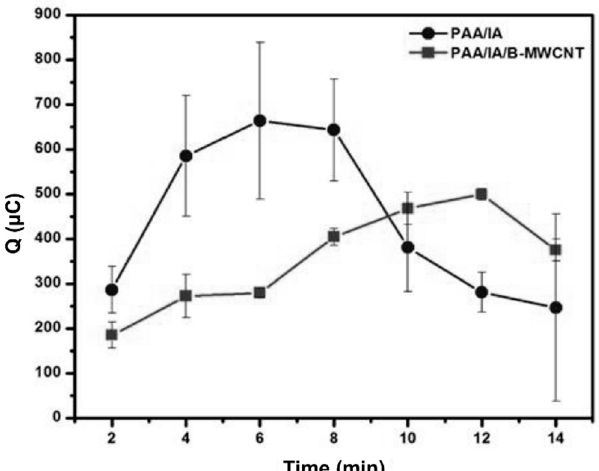
Figure 7. E ff ect of accumulation time on Cd(II) in CPE modified with either PAA-co-IA / NaOH (PAA / IA) or PAA-co-IA / NaOH / B-MWCNT (PAA / IA / B-MWCNT) hydrogel in a solution of Cd(II) 1 × 10 − 3 M + KNO 3 0.1 M at pH 5. Each point was obtained by DPV using the following conditions: The accumulation time was 2 min at open circuit potential under stirring, and the pre-concentrated Cd(II) was reduced to Cd(0) at − 0.95 V for 40 s, followed by anodic stripping (oxidation of Cd(0) to Cd(II)) from − 0.95 to 0.6 V with a 33.3 mV s − 1 scan rate, 40 mV pulses height, 75 ms pulses width, and 5 mV step height. Each point was measured eight times in argon-saturated